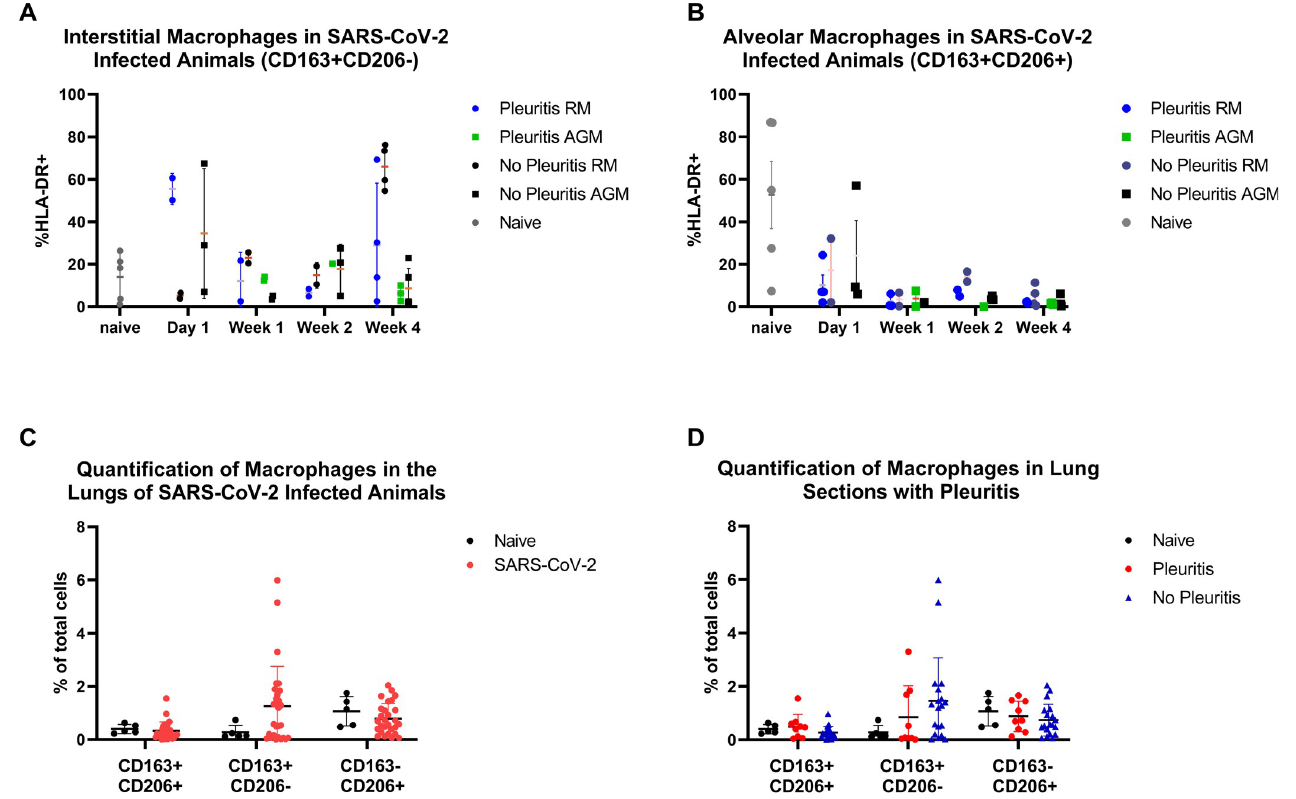
Fig 8. Myeloid cell kinetics. A) Flow cytometry of BAL fluid showed a decrease in alveolar macrophages in SARS-CoV-2 infected animals over the course of the study. The decrease in alveolar macrophages was more pronounced in animals with pleuritic (red). B) Infiltrating interstitial macrophages (CD163+CD206- ) were elevated compared to na ï ve animals both early (d1) and late (necropsy).